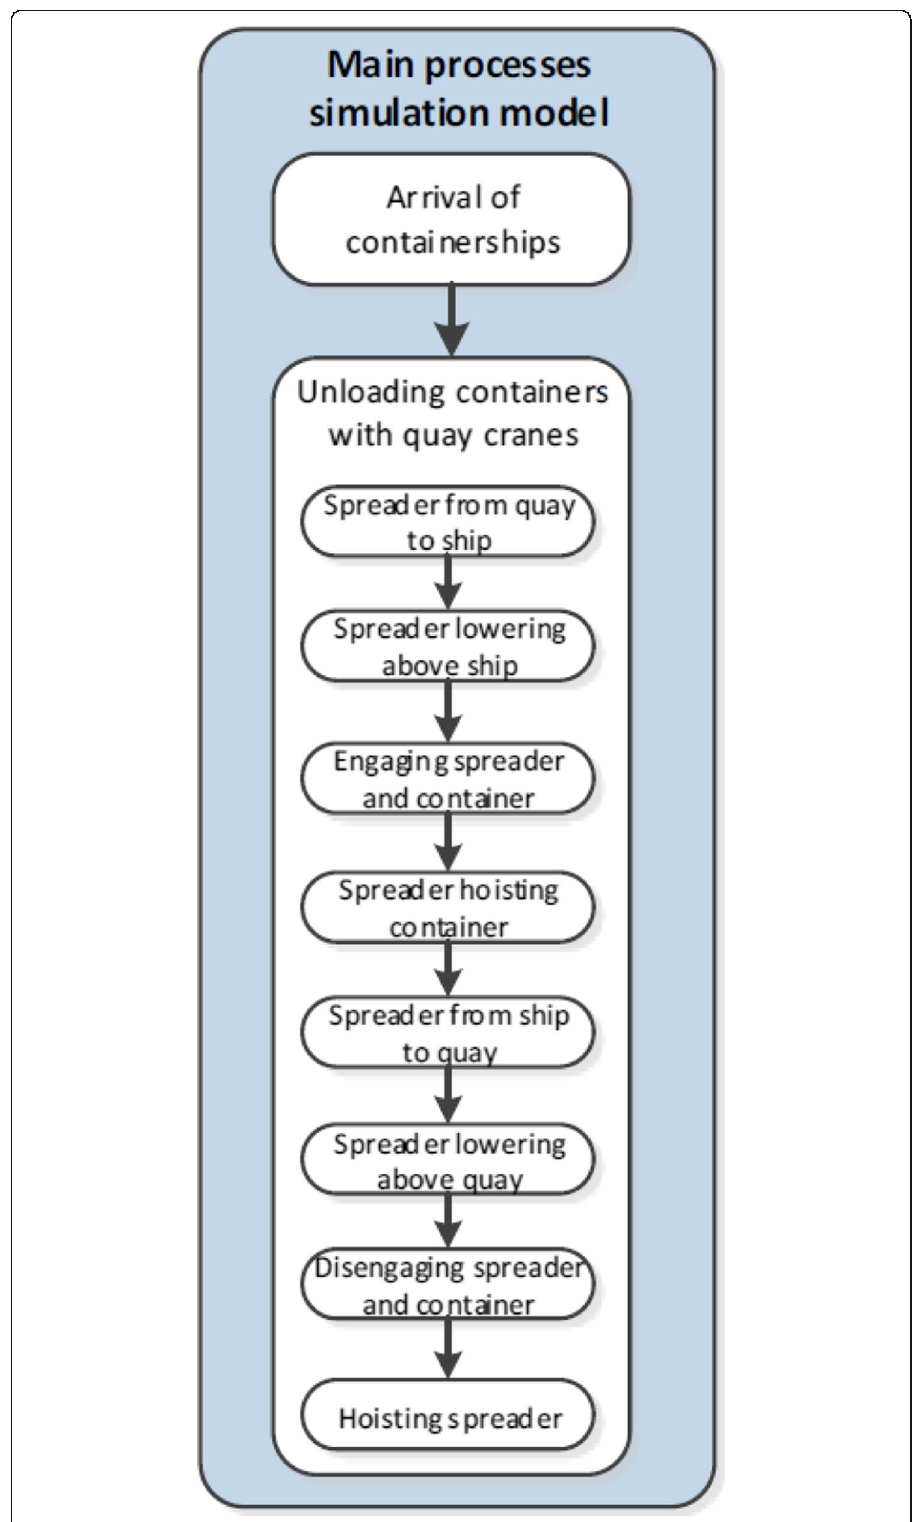
Fig. 4 Main processes of the simulation